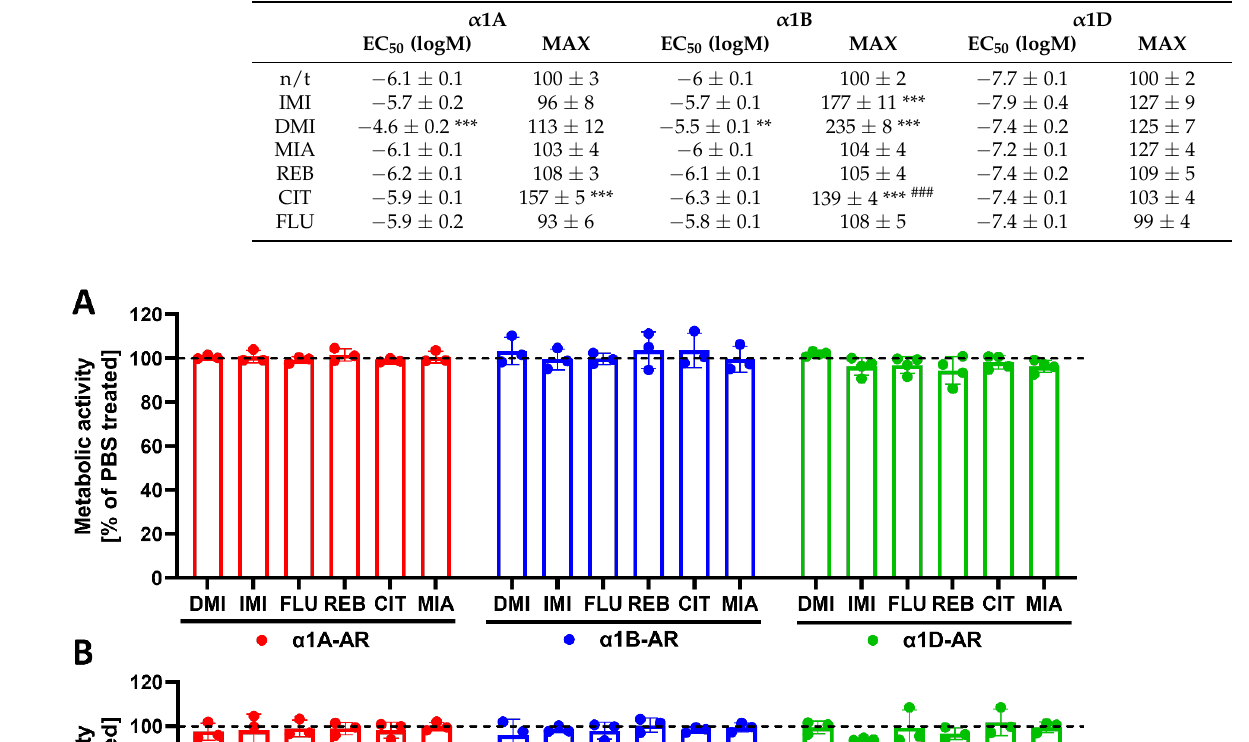
Table 2. Effects of 24 h preincubation with chosen antidepressants on the EC 50 and maximal response (MAX) of the second messenger response to noradrenaline in the α 1A-, α 1B- and α 1D-adrenergic